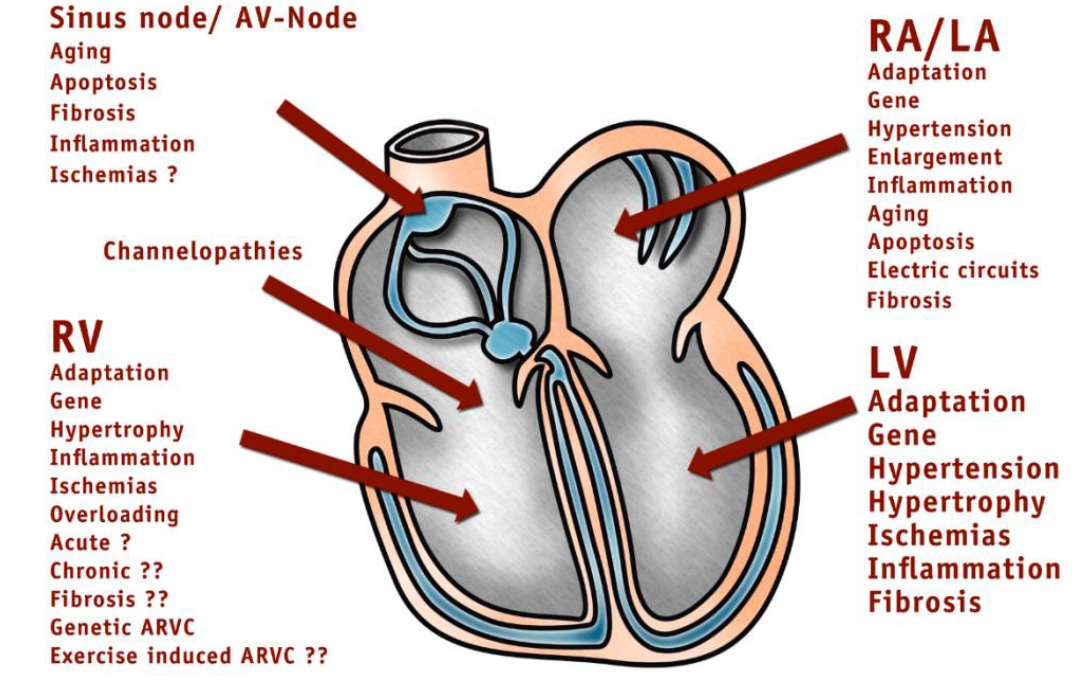
Figure 1. Factors that might influence heart function during endurance